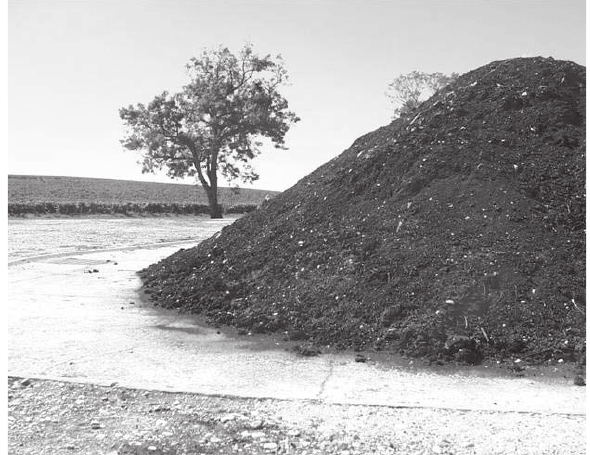
Fig. 1. View of the compost produced in 2004 at Châ- teau Latour (Médoc).